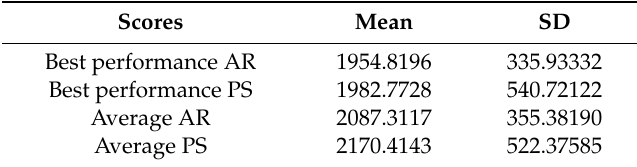
Table 2. Performance comparison between AR and